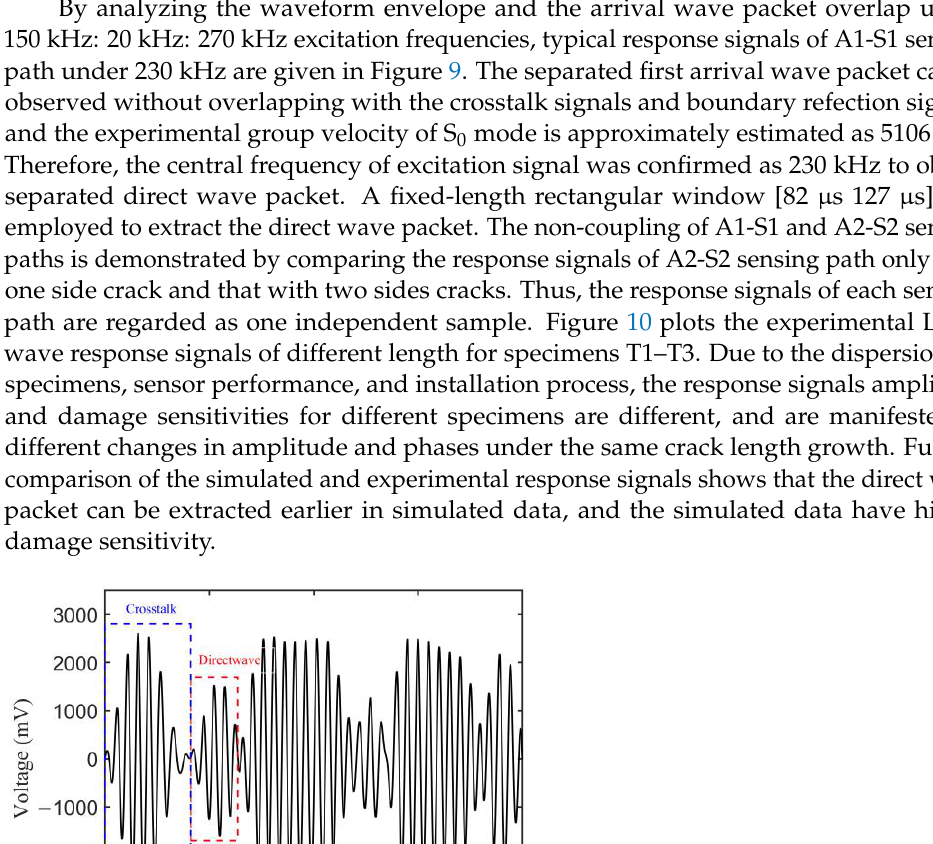
Figure 8. Cracks observed from the microscope of specimen T1 at: ( a ) 59,673 load cycles and ( b ) 70,766 load cycles.